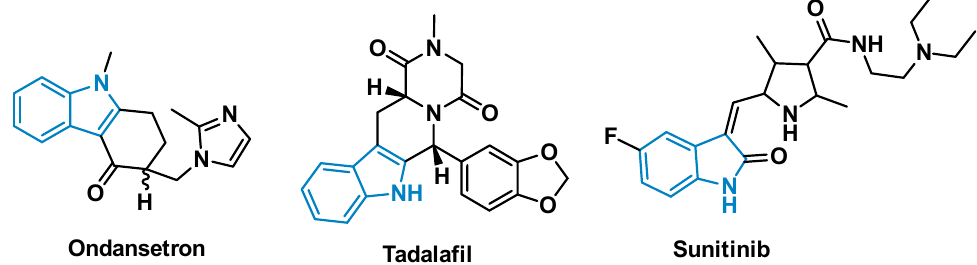
Figure 1. FDA approved indole containing small molecule drugs.